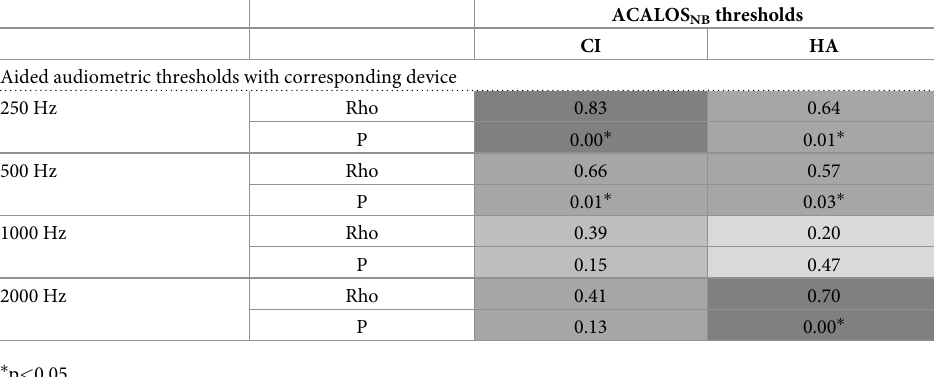
Table 7. Correlations between estimated ACALOS NB threshold values (T5CU) and aided audiometric thresholds within the same modality (CI and HA).